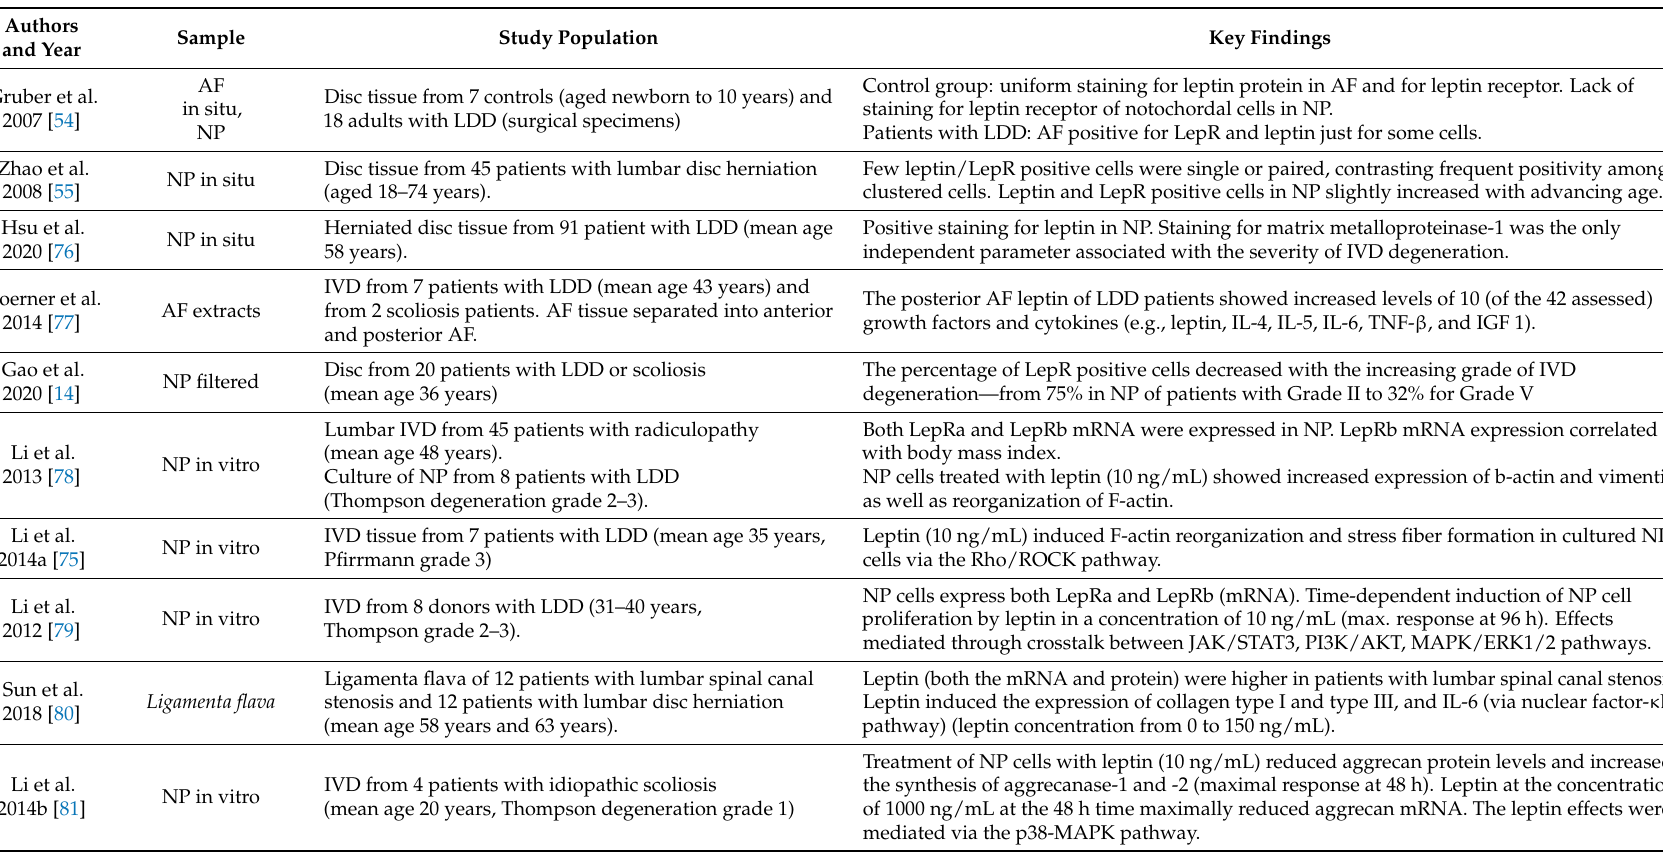
Table 1. Studies investigating leptin signaling in human intervertebral